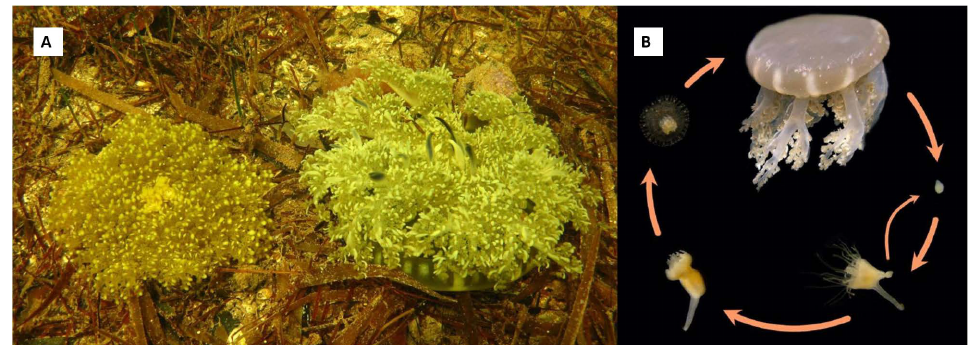
Figure 1. ( A ) Cassiopea frondosa (female) and C. xamachana (male) living together in a deep (3–4 m) channel in Florida Bay. ( B ) Lifecycle of Cassiopea sp. Eggs hatch into planulae larvae, with both stages lacking symbiotic algae. The planulae metamorphose into scyphistomae (polyps) that acquire symbionts from the environment. Scyphistomae can asexually produce buds that settle into polyps. Symbiotic algae are required for scyphistomae to strobilate into ephyra (immature jellyfish) that subsequently develop into male or female adult